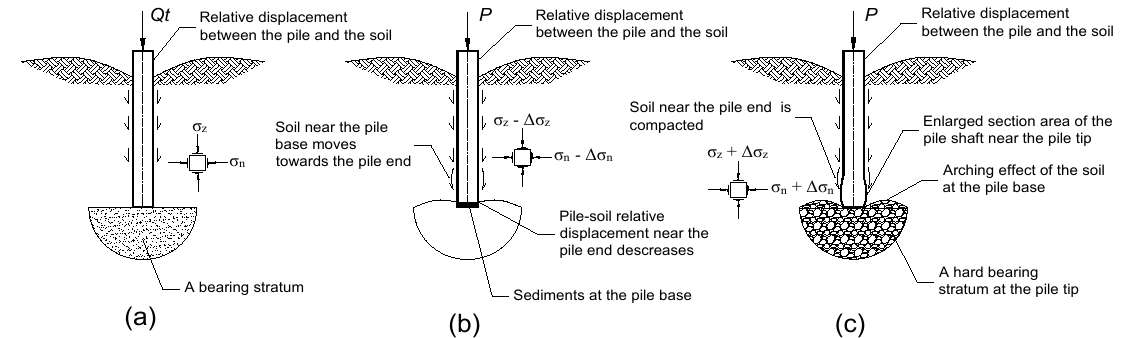
Figure 3. Stress state of soil element near pile end with different soil strengths at pile base (after Zhang et al. [26]).